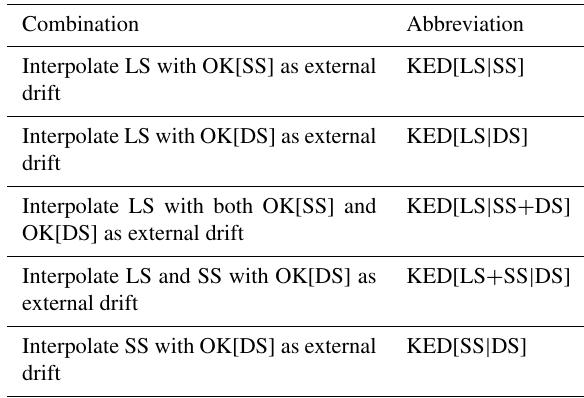
Table 7. Overview of different integration of data types in kriging with external drift (KED) interpolation, where SS is the short se- ries, LS is the long series and DS is the disaggregated daily series. Pooling the data together with the same importance is represented by a ( + ) sign, whereas priority importance (integration through an external drift) is represented by the ( | )